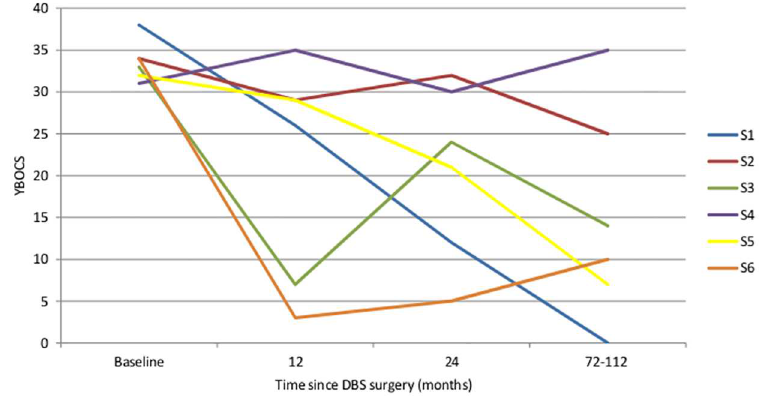
Fig 1. Obsessive-compulsive symptoms across follow-up period. YBOCS = Yale-Brown Obsessive- Compulsive Scale. To improve the clarity of the graph, only data collectedat 12 months, 24 months, and at long-termfollow-upwere includedin the figure.